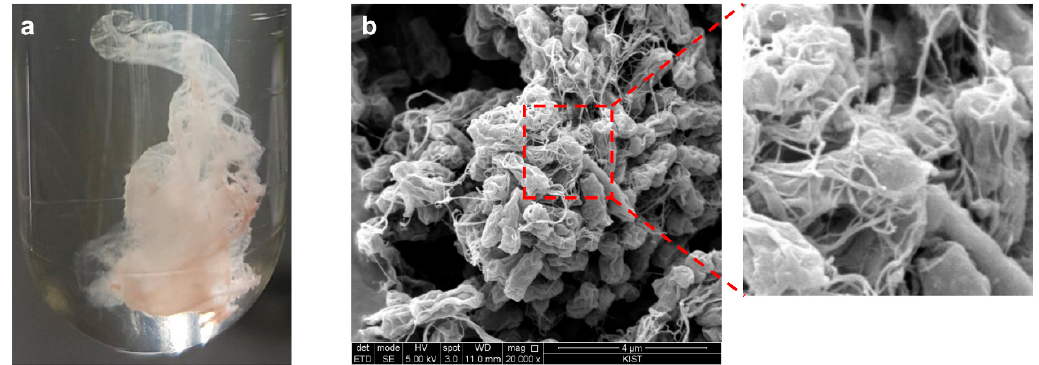
Figure 1. Images of the Methylobacterium hispanicum EM2 strain isolated from mine tailing soil. ( a ) Photograph of the EM2 strain after 48 h cultivation in a liquid culture medium, ( b ) scanning electron microscope (SEM) images of the EM2 strain under 20,000 × and 100,000 × magnification (dashed red box).